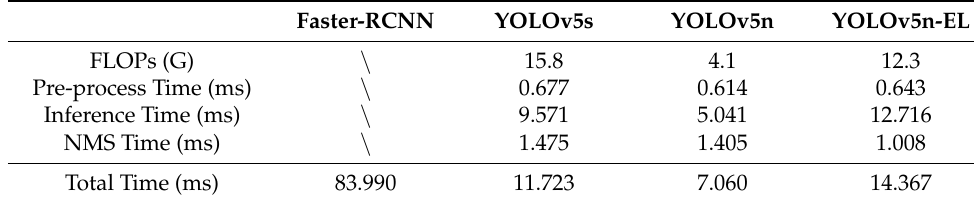
Table 2. The Time and FLOPs Consumption of Detectors.